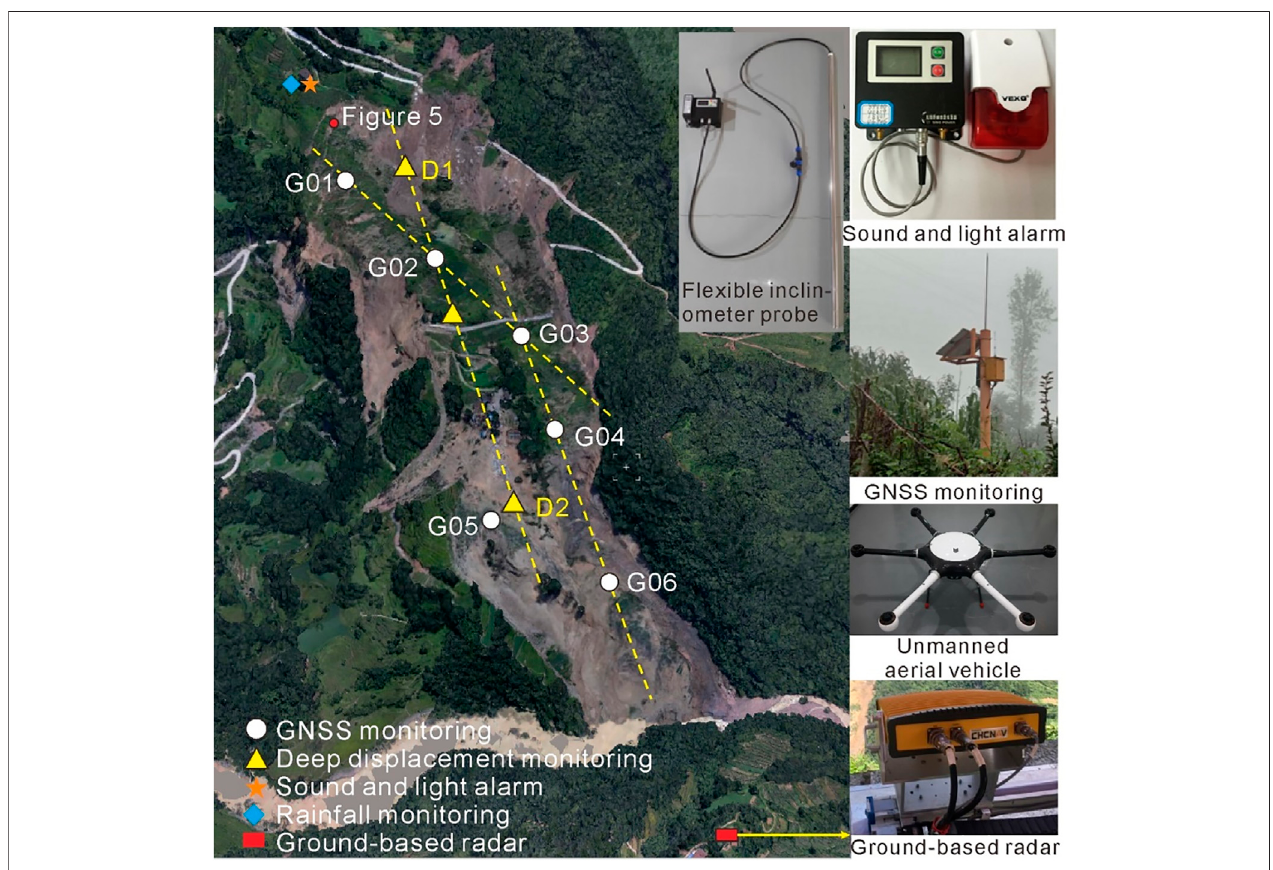
FIGURE 3 | Monitoring system of the failure landslide and photographs of the